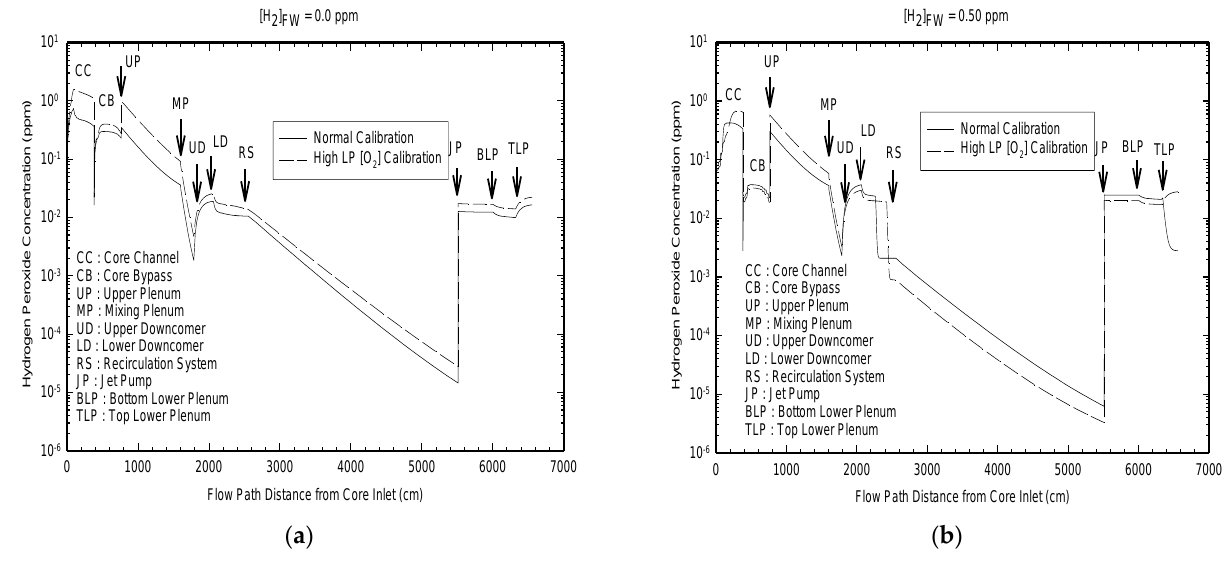
Figure 14. Calculated [H 2 O 2 ] around a BWR PHTS for ( a ) NWC and ( b ) HWC with [H 2 ] FW = 0.5 ppm. Note that two calibrations are included: the normal calibration on [O 2 ] in the autoclave valved into the recirculation system and calibration of the [O 2 ] measured in the LP.